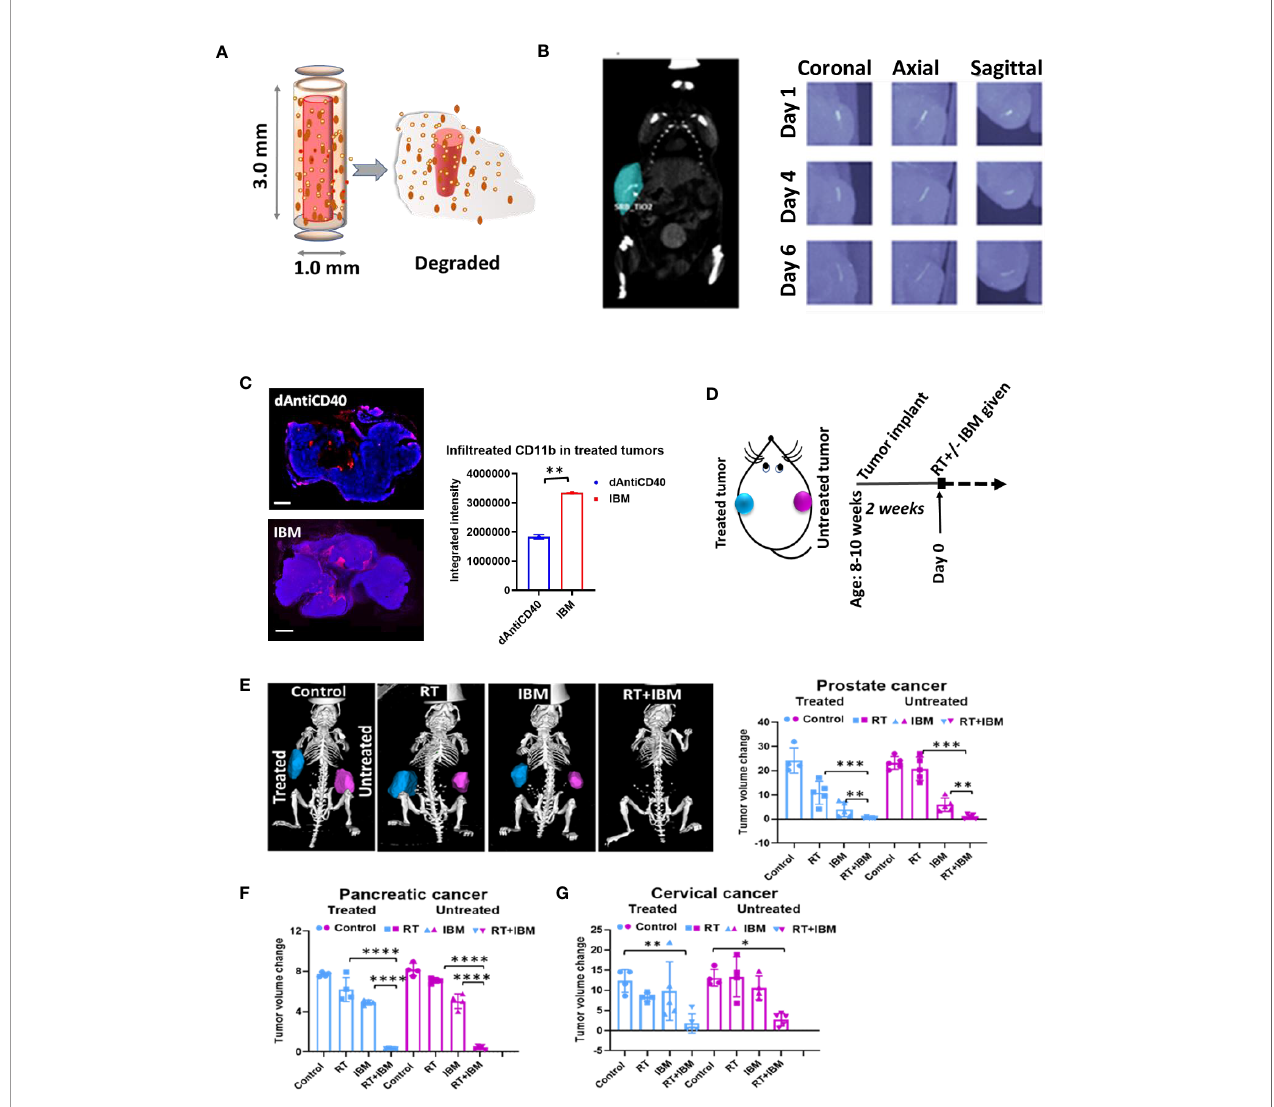
FIGURE 2 | Anti-CD40 agonist-loaded immune-biomaterial (IBM) may provide imaging contrast and induces higher immunogenicity in treated tumor microenvironment. (A) Schematic diagram of IBM made of immunogenic polymer with antibody core (red), which releases as it biodegrades. (B) CT image showing IBM in tumor (blue color) highlighted using Imalytics software (left) and gradually fading CT images of IBM from days 1 to 6, as polymer biodegrades (right). (C) Fluorescent images and representative bar graph of the average fl uorescent intensity of immuno fl uorescence-stained prostate cancer tissue treated with mouse CD11b + antibody at posttreatment day 7. Corresponding immuno fl uorescence (merged) pictures showing in fi ltration of CD11 + dendritic cells (red) in tumor tissue. Cancer cell nucleus (blue, DAPI) when IBM or dAntiCD40 was given intratumorally ( n = 3). Scale bar is 2,000 µm. (D) Treatment design and (E) prostate tumors generated from TRAMP-C1-derived castration-resistant prostate cancer cells treated with IGRT (5 Gy) and/or IBM, representing CT images (Imalytics software analyzed) of animals from different treatment cohorts with treated tumors (blue) and untreated tumors (pink). Bar graph represents treated and untreated tumor volumes on day 10 posttreatment ( n = 5). (F, G) The tumor volumes of pancreatic ( n = 5, IGRT 5 Gy 16 ) and cervical cancer ( n = 5, IGRT 6 Gy 29 ), respectively 10 days after the same treatment regimen. Data represent the mean ± SD. * p < 0.5, ** p < 0.01, *** p < 0.001, **** p <